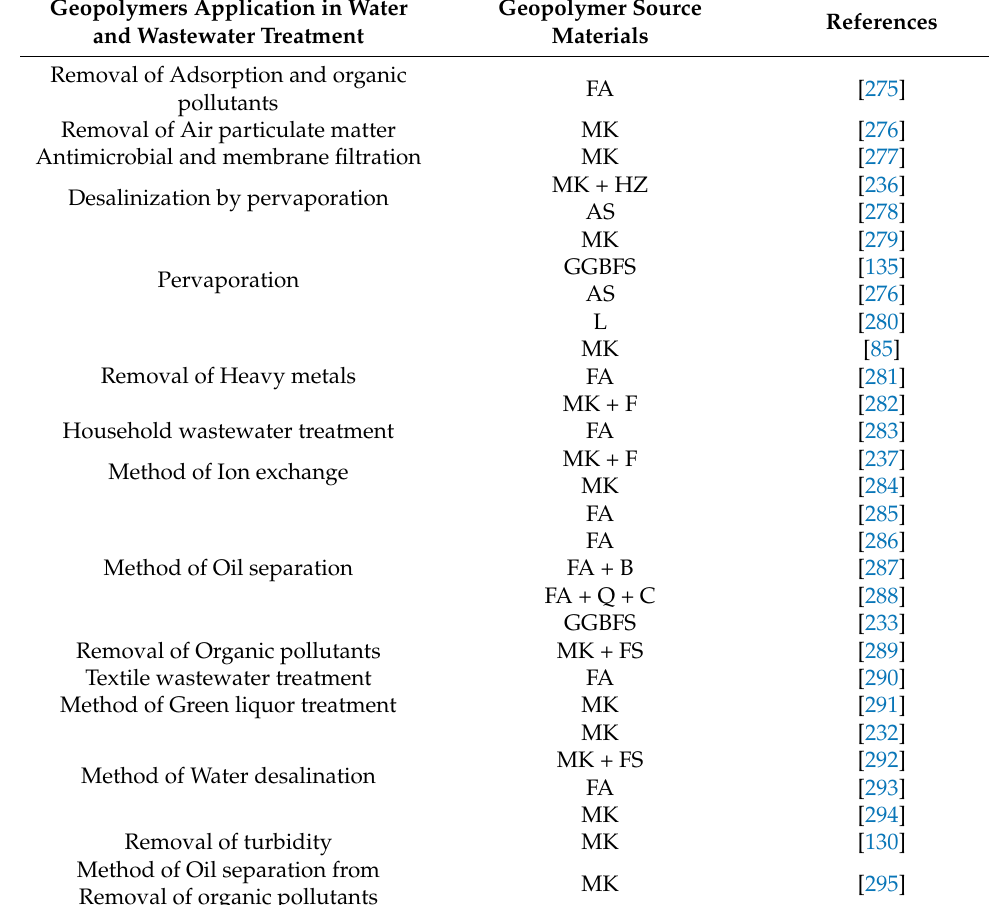
Table 3. Geopolymers application in water and wastewater